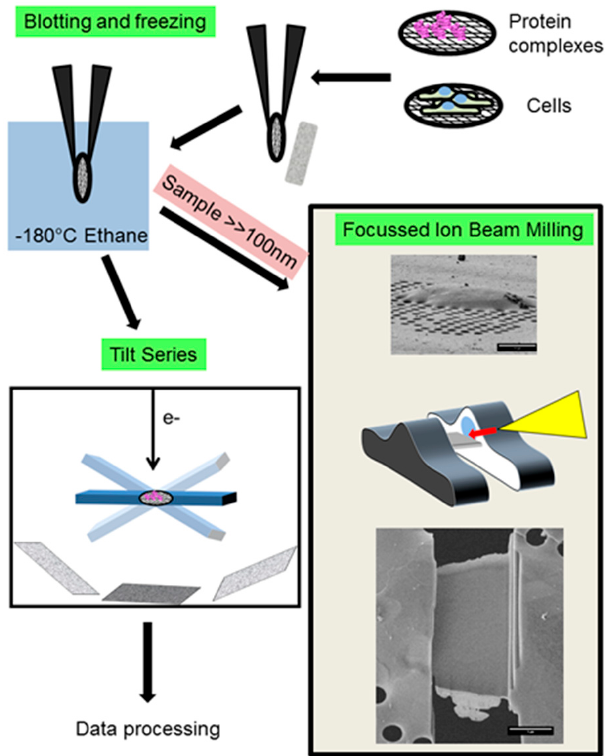
Figure 4. Schematic workflow for sample preparation and data collection. Samples can be isolated complexes, cell compartments or cells grown/settled on grids. After excess liquid is blotted away, the sample is plunge-frozen (high-pressure freezing is excluded here). If samples are sufficiently thin, one can proceed to collection of tilt series right away. Cells and thick samples can be processed with focused ion beam milling (beige box). The SEM image shows a cell on holey carbon. During the milling process (see middle graphic illustration), cell material is ablated by sputtering Ga2+ ions on the cell with an ion gun (yellow). As a result, we obtain a lamella thin enough for imaging (lower picture). The SEM images were kindly provided by Prof Linda Sandblad, Umeå Core Facility for Electron Microscopy.